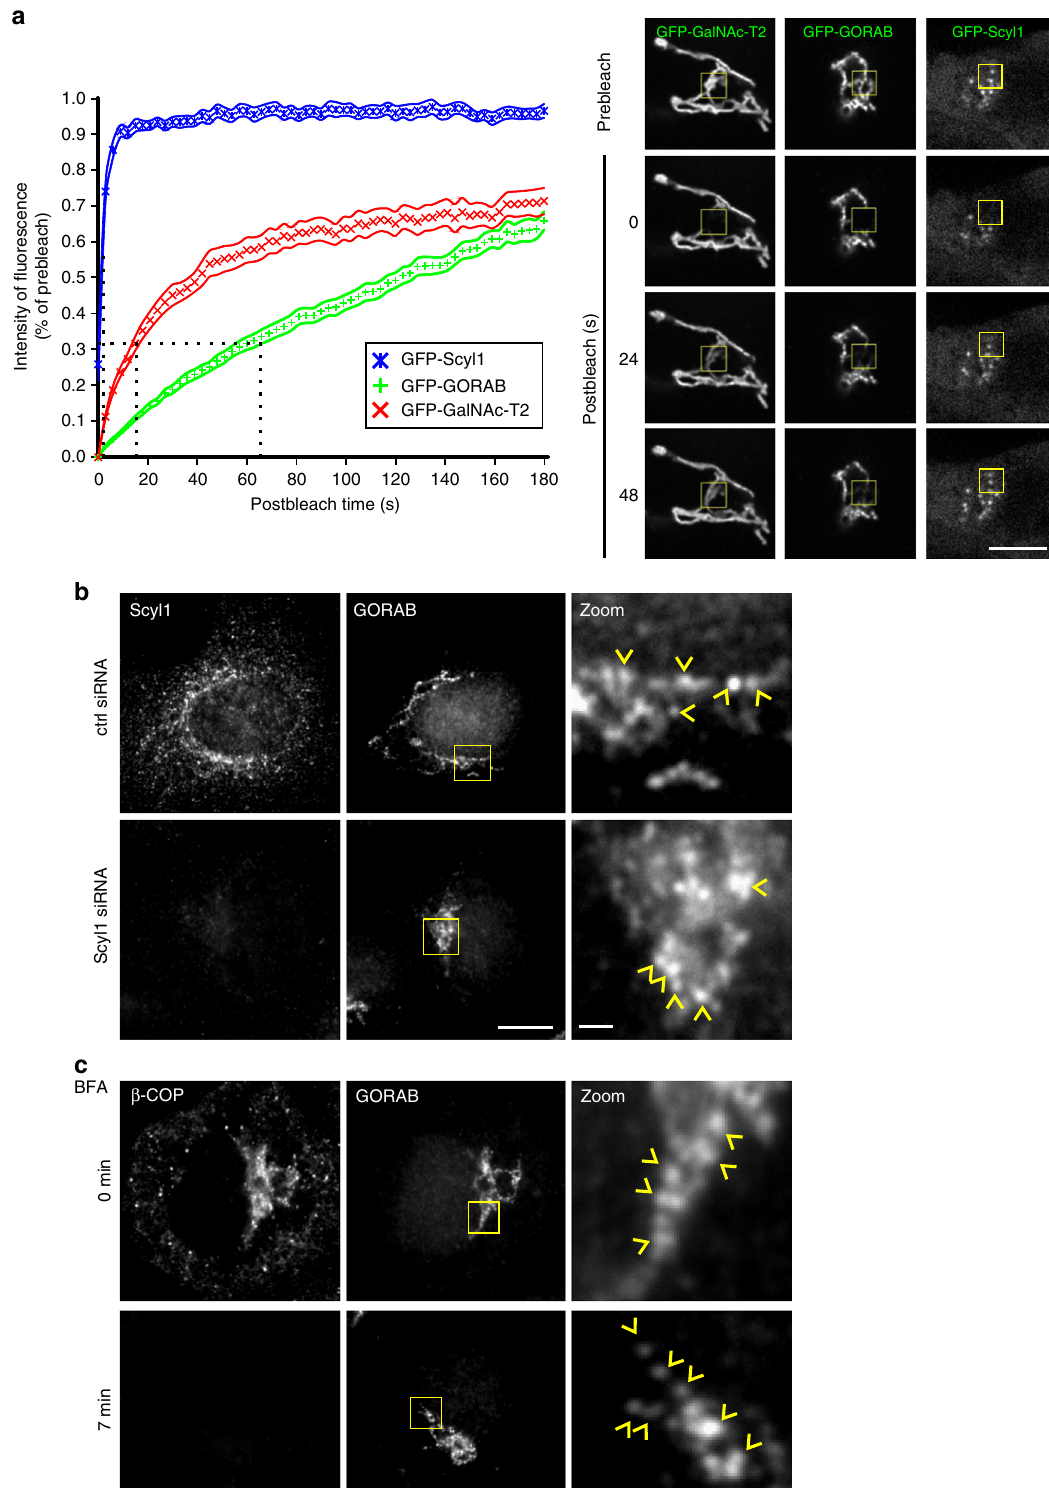
Fig. 3 GORAB domains are stable entities. a Fluorescence recovery after photobleaching. Left, FRAP recovery curves for GFP-GalNAc-T2, GFP-GORAB and GFP-Scy1. Means with SEM for GFP-GalNAc-T2 ( n = 27 cells), GFP-GORAB ( n = 28 cells) and GFP-Scyl1 ( n = 18 cells). Dotted lines mark points of half- time recoveries. Right, representative HeLa GFP-GalNAc-T2, HeLaM GFP-GORAB and HeLaM GFP-Scyl1 cells at pre-bleached and selected post-bleached states. Bleached region of interests are marked with yellow boxes. Scale bar, 10 µ m. b Localization of GORAB in Scyl1-depleted cells. HeLa cells transfected with control or Scyl1 siRNA were fi xed and labeled with antibodies to Scyl1 and GORAB. Scale bars, 10 µ m and 1 µ m. GORAB domains are marked with yellow arrowheads. c Localization of GORAB in BFA-treated cells. HeLa cells were exposed to 5 µ g/mL BFA for 7 min prior to fi xation and labeling with antibodies to Scyl1 and GORAB. Scale bars, 10 µ m and 1 µ m. GORAB domains are marked with yellow